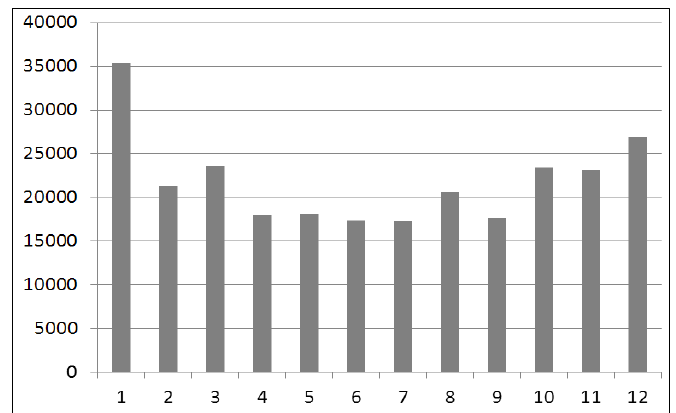
Figure 7: Graphic of the Relative humidity % during the period of